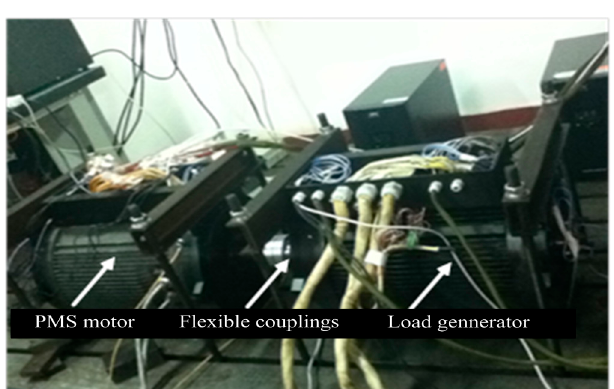
Figure 8. Inverter platform.